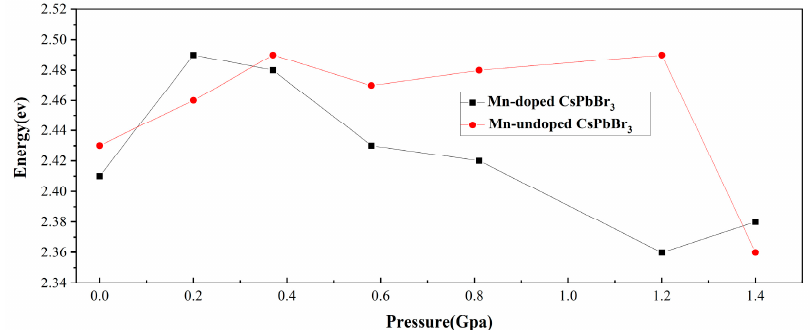
Figure 5. ( a , b ). Transient absorption spectra of Mn-doped and undoped CsPbBr 3 under different pressures.